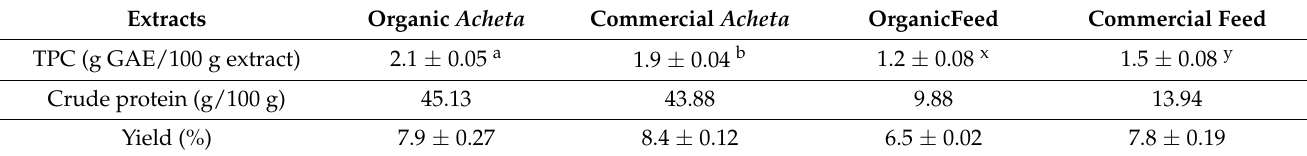
Table 1. The total phenolic content (TPC) and crude protein of A. domesticus and feed extracts.